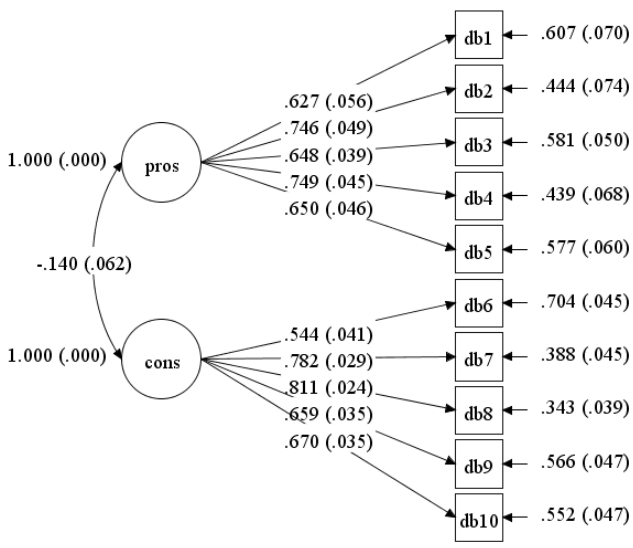
Figure 1. Standardised item loading for Model-1.